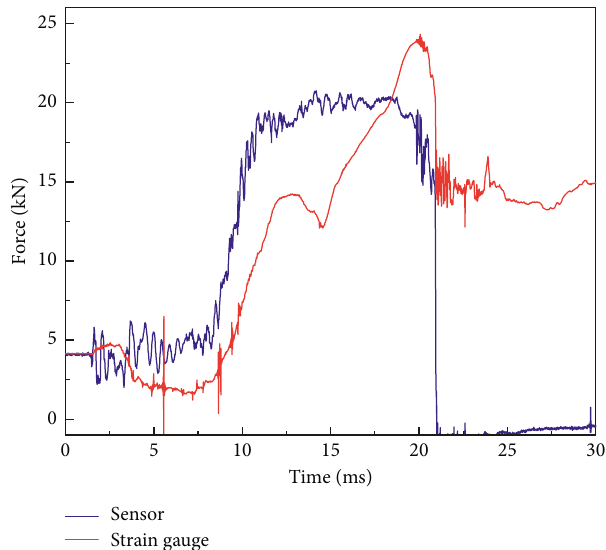
Figure 16: The comparison of the strain gauge and the sensor signal.